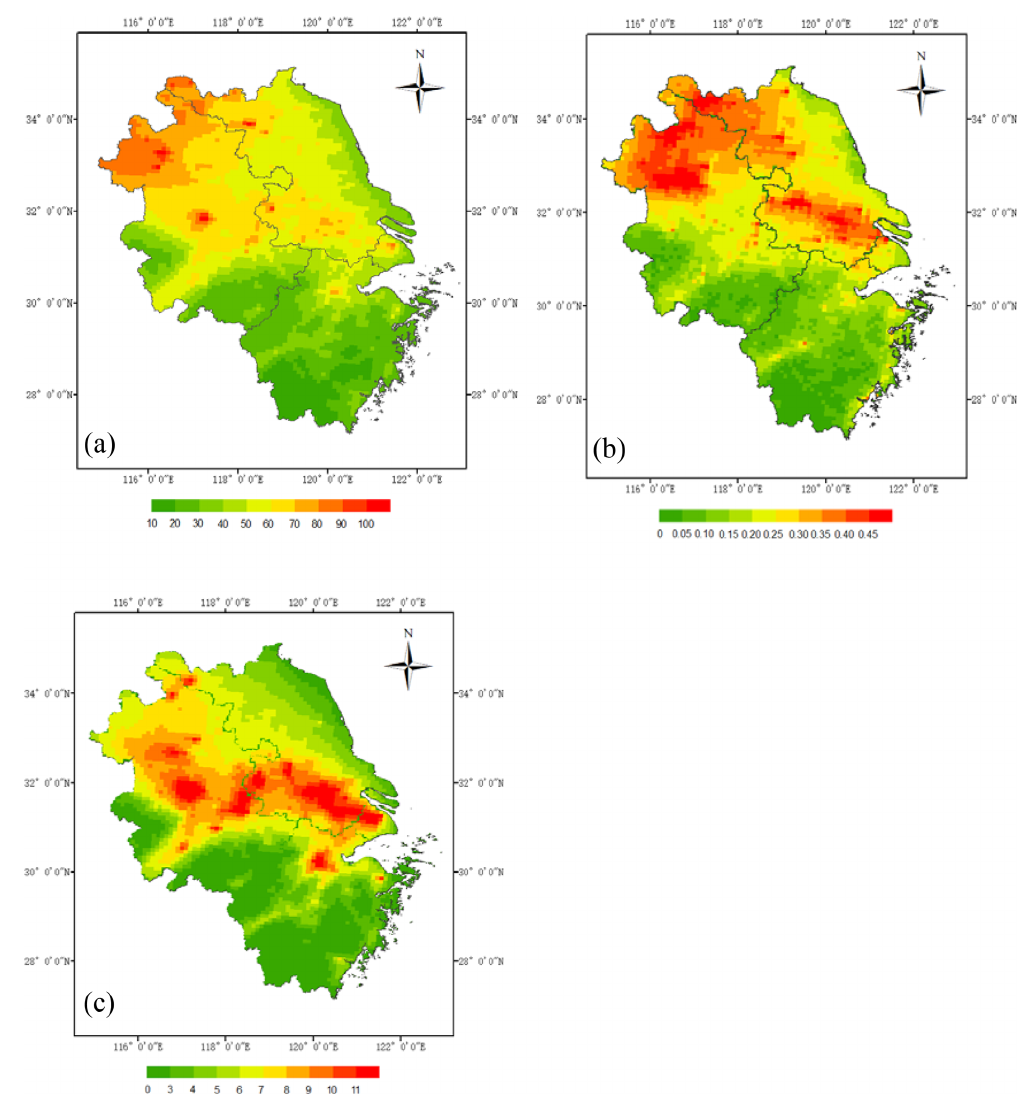
Figure 5. The spatial distributions of the annual PM 2 . 5 concentrations (average of January, April, July, and October) for case 2 (a) and the reduced annual PM 2 . 5 concentrations for cases 3 (b) and 4 (c) in the YRD region (unit: µgm − 3 ). Note the different color ranges in the panels for easier